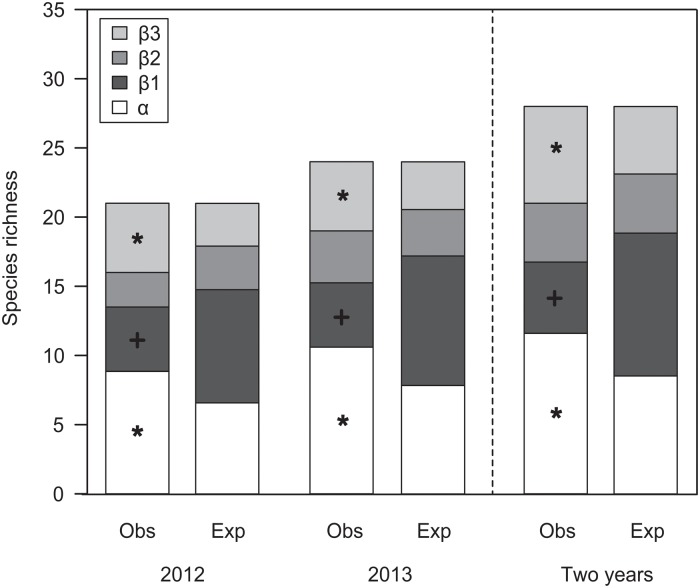
Full hierarchical analysis of diversity partitioning for composition of dung beetles.α = average local diversity, β1 = diversity among sites, β2 = diversity among areas, β3 = diversity among mainland-island. The observed partitions (Obs) are compared with the expected values (Exp) as predicted by the null model based on 999 randomizations. Black star: Exp < Obs, p < 0.05. Black cross: Exp > Obs, p < 0.05.